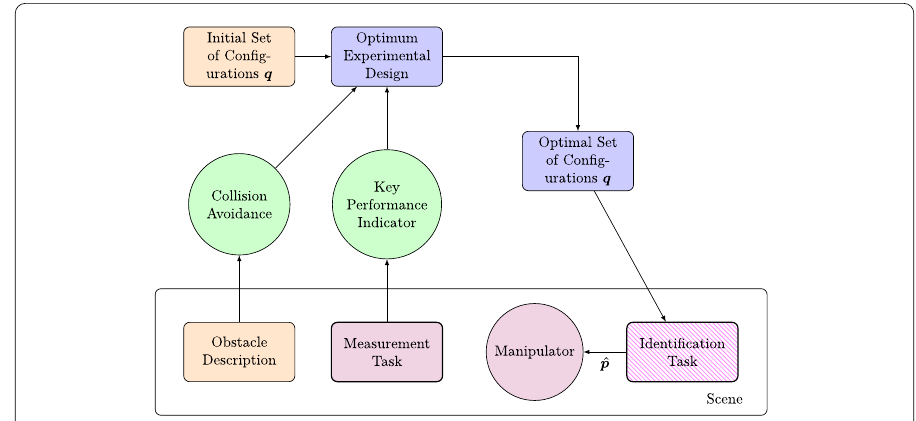
Figure 5 Overview of the parameter identification procedure under consideration. The figure shows the general approach to parameter identification of industrial manipulators and mechanisms using KPIs. We assume the manipulator has to perform a measurement task on certain TCP positions s requiring a high precision. These positions are considered as KPIs for the parameter identification procedure. The required precision is achieved by combining a (re-)identification of the parameters with the actual work cycle of the manipulator, i.e. whenever the manipulator is idle it can sequentially identify itself. Both the measurement and parameter identification task take place in the same scene. From scene and manipulator model the necessary obstacle descriptions are required to setup the collision avoidance for the OED problem. The OED problem will find an optimal set of configurations q for the optimization problem considering the collision avoidance and the chosen KPI from a given set of initial configurations. Whenever the manipulator performs an identification task, the internal kinematic model is updated with the current optimal parameter values p true .